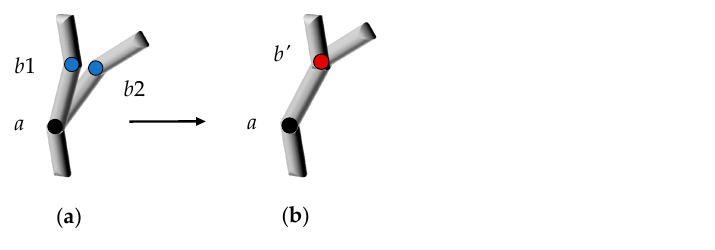
Figure 5. The similarity between vertices is checked according to different weights. ( a ) Points b 1 and b 2 have high similarity. ( b ) Point b ′ is merged from b 1 to b 2, thus simplifying the tree skeleton.